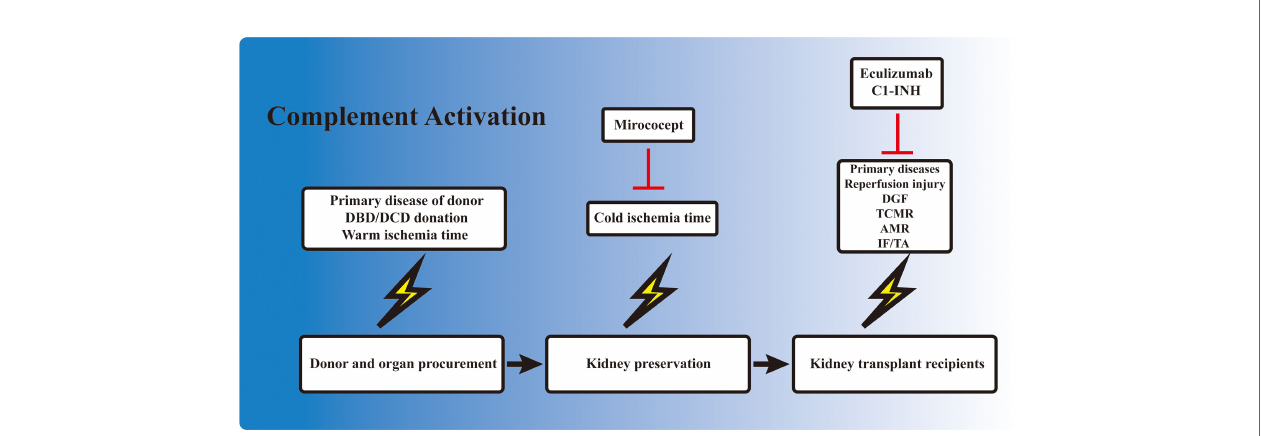
FIGURE 2 | Involvement of complement activation in kidney transplantation. Activation of the complement cascade is involved before organ procurement, during ex vivo preservation, and also in kidney allograft recipients. The complement system is activated in deceased donors due to the unstable hemodynamics and impaired homeostasis. The kidney also undergoes a short warm ischemia period during procurement, which potentially activates the complement system. Ex vivo preservation of the kidney is accompanied with a cold ischemia period, which is also associated with complement gene expression. When the allograft is transplanted into the recipient, the kidney allograft fi rst undergoes a reperfusion injury, and the subsequent delayed graft function (DGF) in certain cases. T-cell- and B-cell-mediated rejection is also activated and regulated by the complement components. Finally, the development of interstitial fi brosis/tubular atrophy (IF/TA), including the activation of fi broblasts, is associated with complement factors. Mirococept has been tested in the EMPIRIKAL trial to reduce ischemia – reperfusion injury (IRI). Clinical trials of eculizumab and C1-INH mainly focused on the reduction of DGF or the prevention/treatment of antibody-mediated rejection (AMR) in kidney transplant